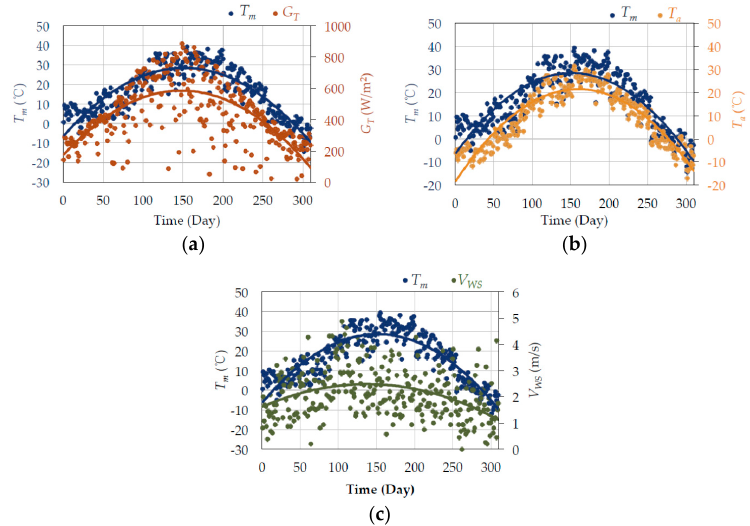
Figure 5. Scatter diagrams and fitting curves between each MIF and PV module temperature: ( a ) PV module temperature and solar irradiance; ( b ) PV module temperature and ambient temperature; and ( c ) PV module temperature and wind speed.